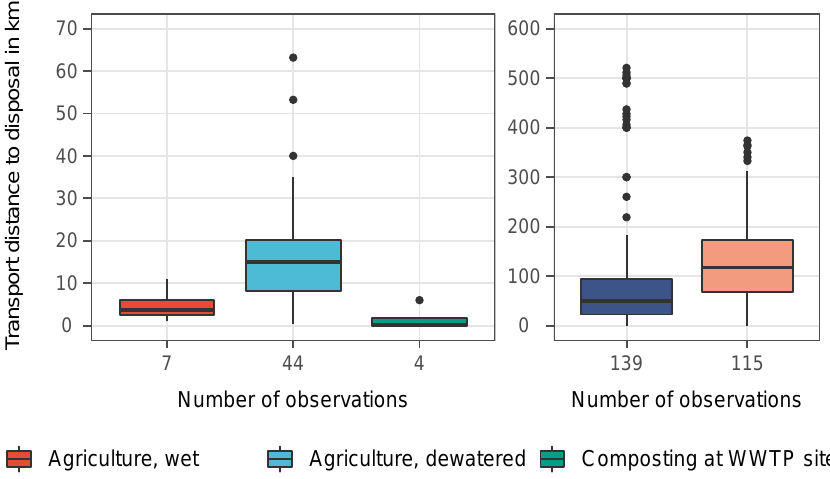
Figure 10. Distance of sewage sludge transport to disposal as a function of their disposal route. Statistical values are provided in Table